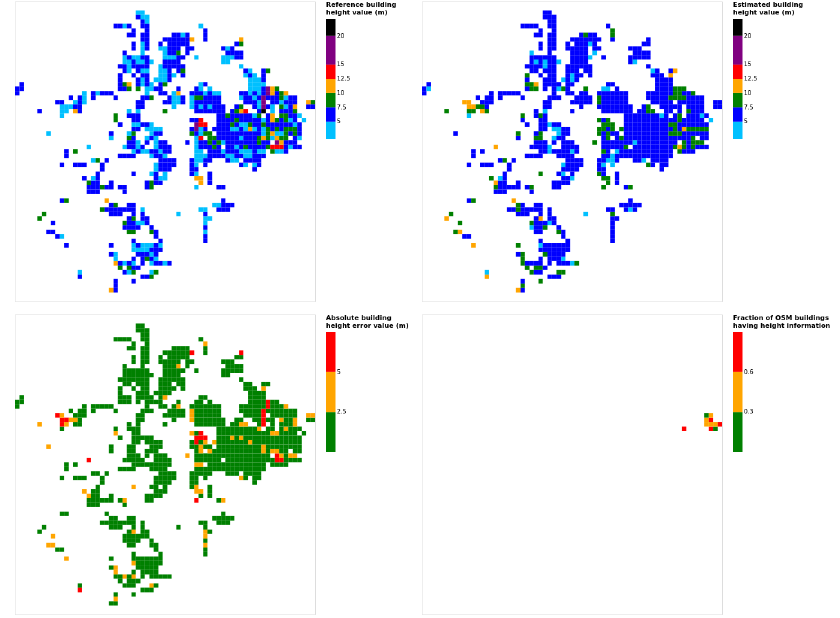
Figure B5. Results for the commune at grid cell (upper left panel) reference building height, (upper right panel) estimated building height, (lower left panel) absolute building height error, and (lower right panel) fraction of OSM buildings that have height information. For all panels except the lower right, only cells that have buildings – with at least 90% of their buildings having no height value in OSM – are displayed.